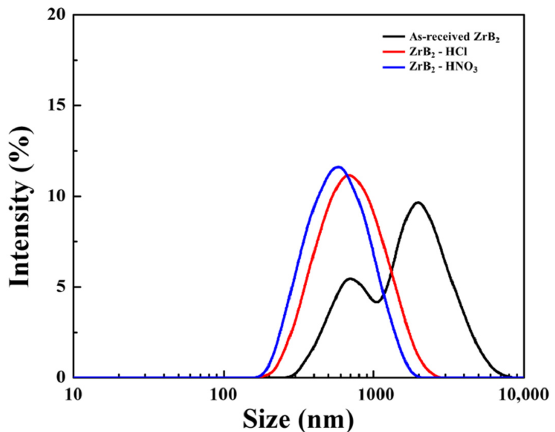
Figure 6. Particle size distribution (PSD) of as-received ZrB 2 , HCl-treated ZrB 2 , and HNO 3 -treated ZrB 2 particles.